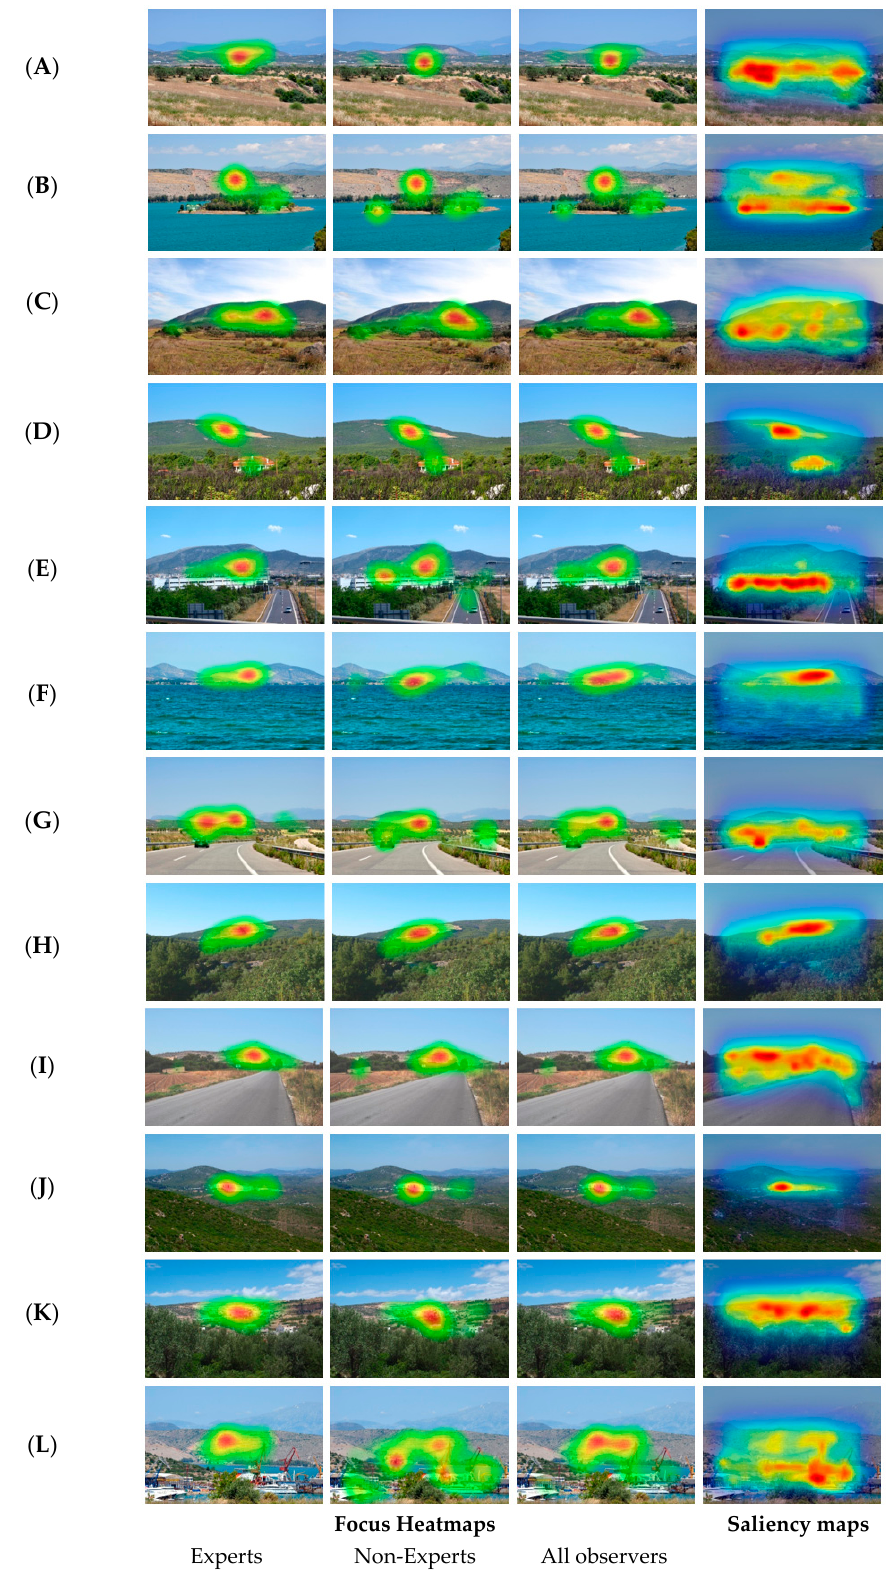
Figure 2. Focus heatmaps and saliency maps for each of the 12 mining landscapes of Figure 1 (rows). The focus heatmaps result from the gaze movements of the experts, non-experts, and all observers. The saliency maps at the rightmost column of the figure are computed based on the GBVS model.